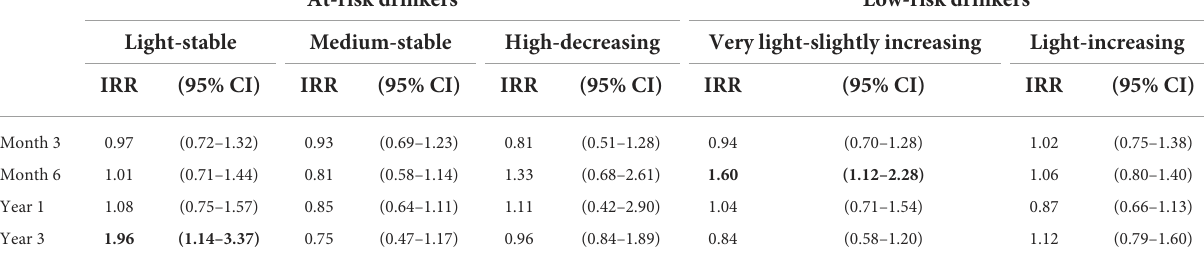
TABLE 2 Study group differences (net changes) in drinks per week over 3 years according to trajectory class. At-risk drinkers Low-risk drinkers Light-stable Medium-stable High-decreasing Very light-slightly increasing